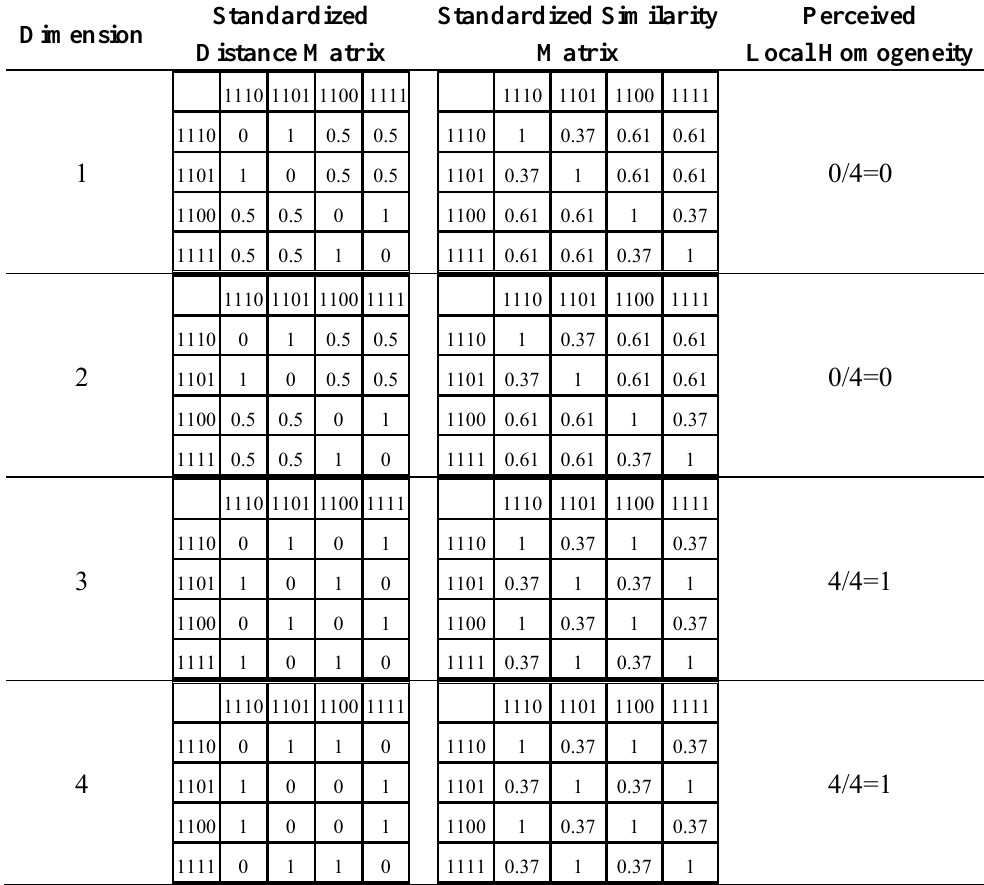
Table 5. The distance and similarity matrices associated with the computation of the local homogeneities of the stimulus set A: There are 4 structural kernels and these are listed in the last column under the perceived local homogeneity measure. Combined they form the manifold of the stimulus set